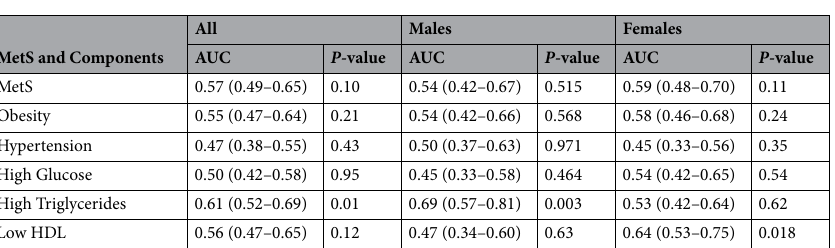
Table 4. Area under the curve for metabolic syndrome and its components against ZAG. Data presented as Area Under the Curve (AUC) and 95% CI. P -value < 0.05 considered significant.